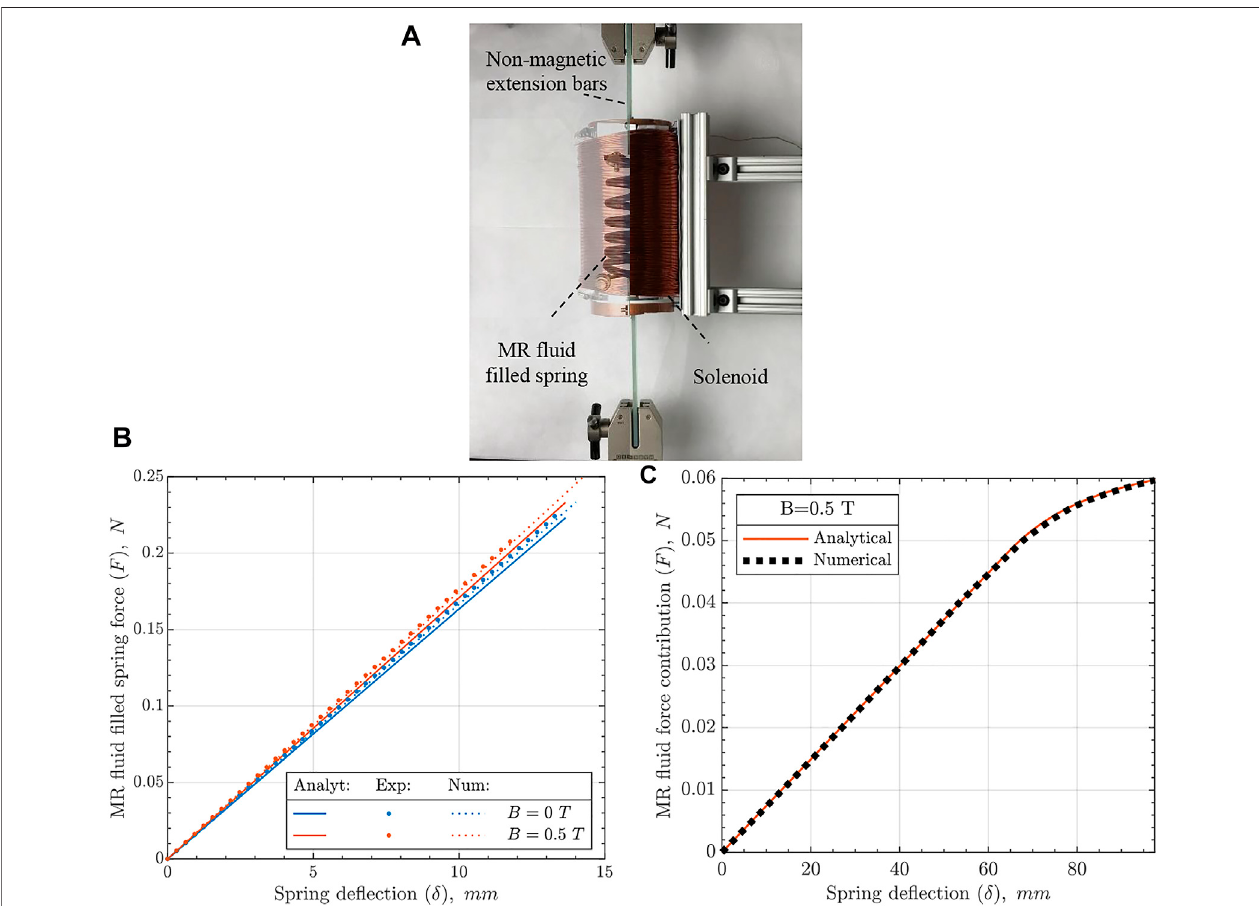
FIGURE 4 | (A) Static test setup with the spring placed inside the solenoid and connected to a tensile machine through non-magnetic extension bars (left side is transparenttoshowthespring), (B) staticresponseofMR fl uid fi lledspring(smallerspringde fl ection rangeisusedtokeep thespringwithintheuniformmagnetic fi eldof the solenoid during the experiment), (C) numerical and analytical estimation of MR fl uid force vs. spring de fl ection.